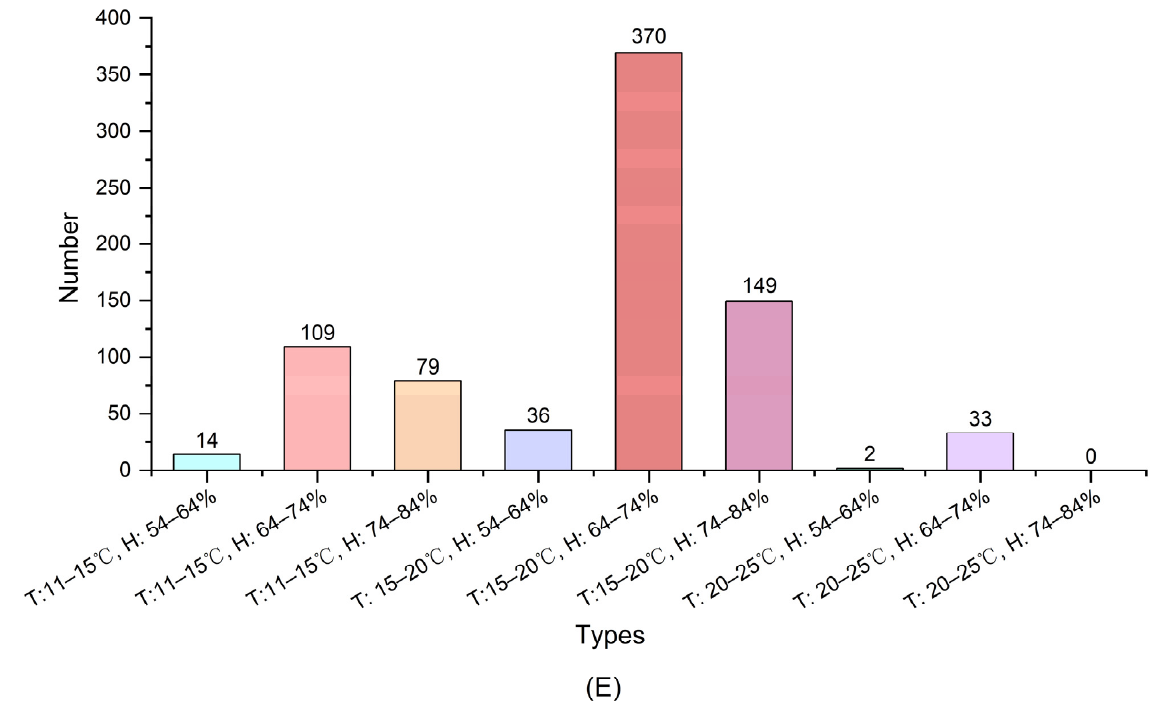
Figure 4. Distributions of LAB in different regions of Yunnan. ( A ) Average annual temperature in 84 regions; ( B ) average annual humidity in 84 regions; ( C ) the most frequently isolated strains in 84 regions; ( D ) heat map of the number of LAB species in 84 regions of Yunnan; ( E ) the number of LAB at different temperature and humidity. T, temperature; H, humidity.